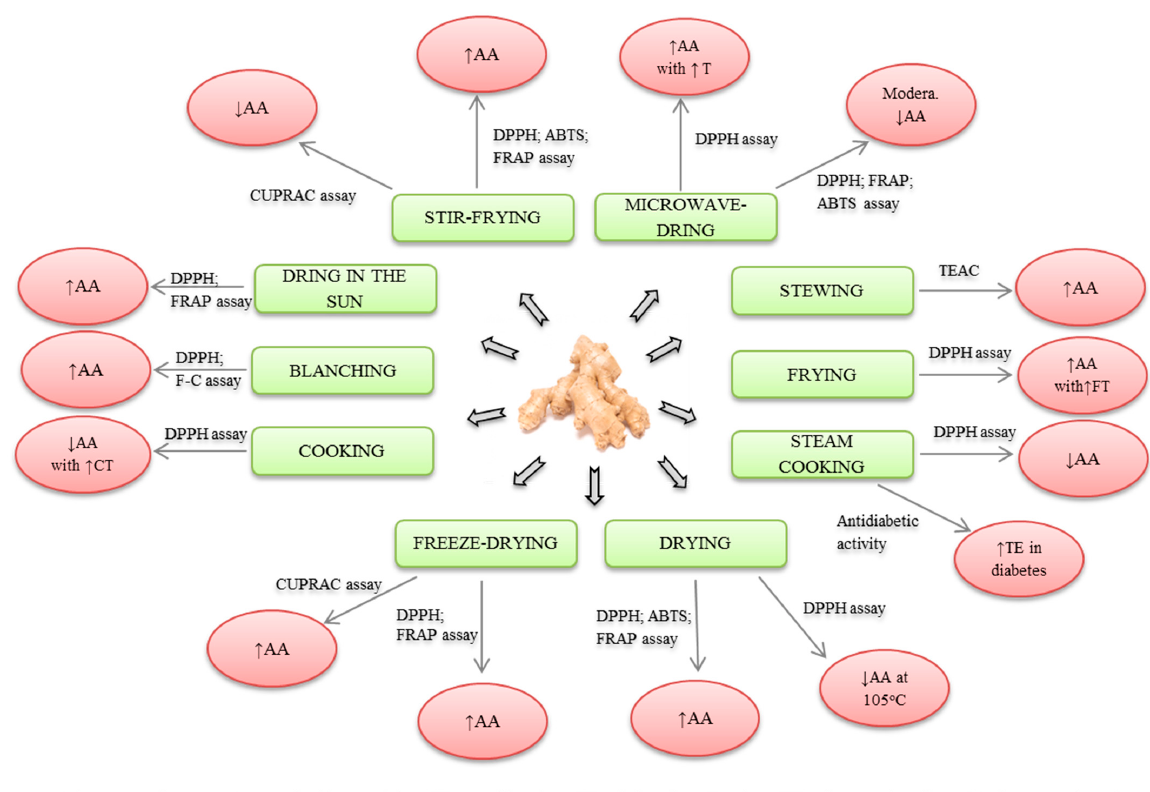
Figure 1. Selected types of thermal treatment and their effect on the activity of ginger rhizome.